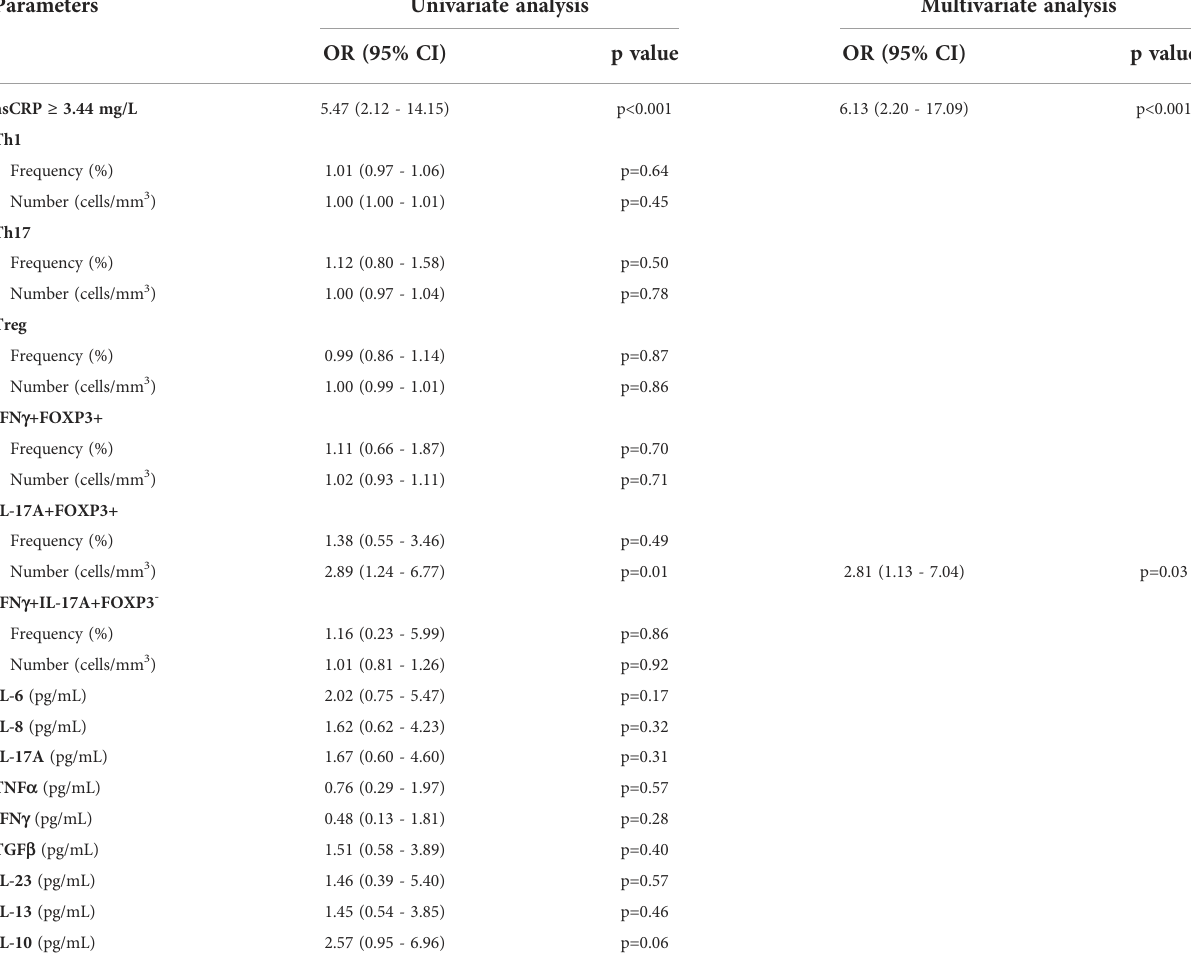
TABLE 3 Univariate and multivariate analysis of biological parameters associated with the risk of further relapse.